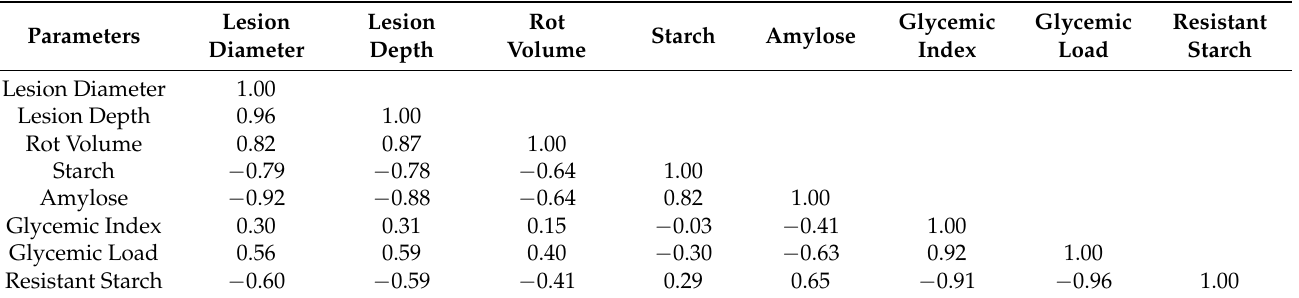
Table 1. Pearson correlation coefficient of the different parameters in Kufri Jyoti and Kufri Frysona that were infected with control (no fungal infection), FSam, FSol, and FSam + Fsol for 0, 20, 40, and 60 d of